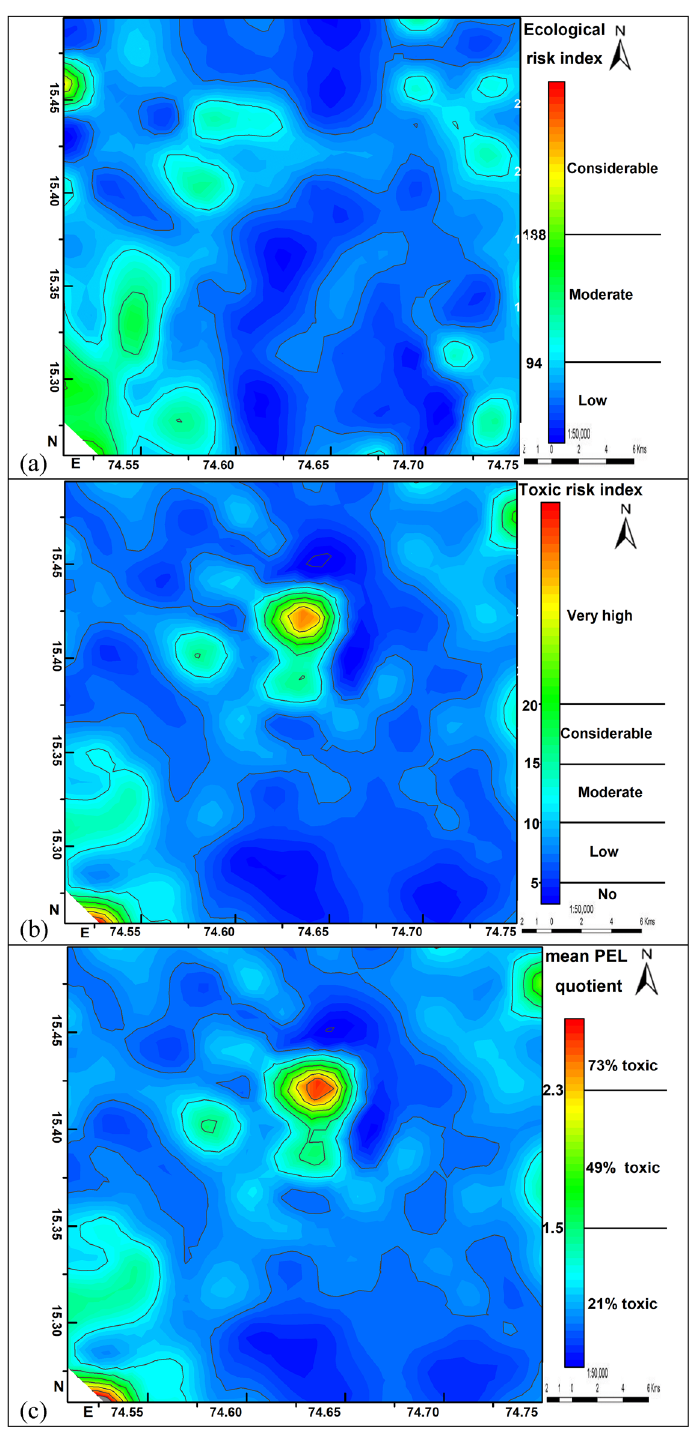
Figure 6. Spatial distribution of potential risks assessed by ( a ) ecological risk index, ( b ) toxic risk index, and ( c ) mean probable-effects-levels quotient